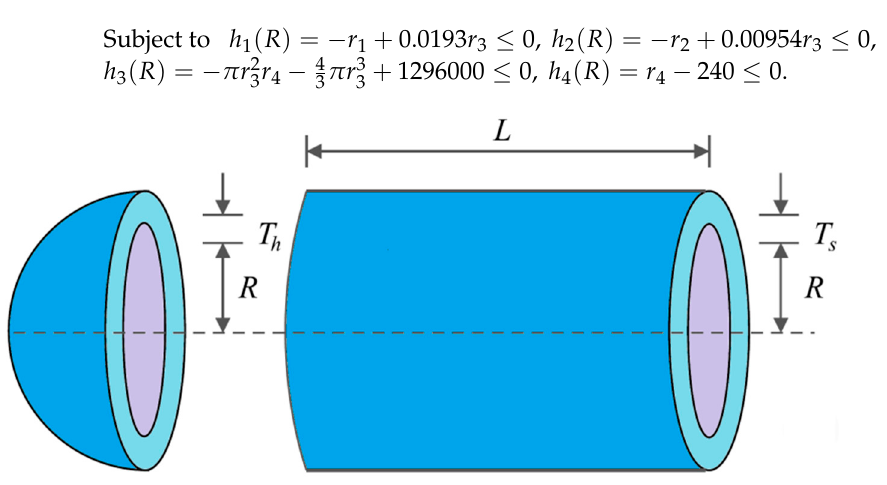
Figure 9. Sketch map of the pressure vessel design.